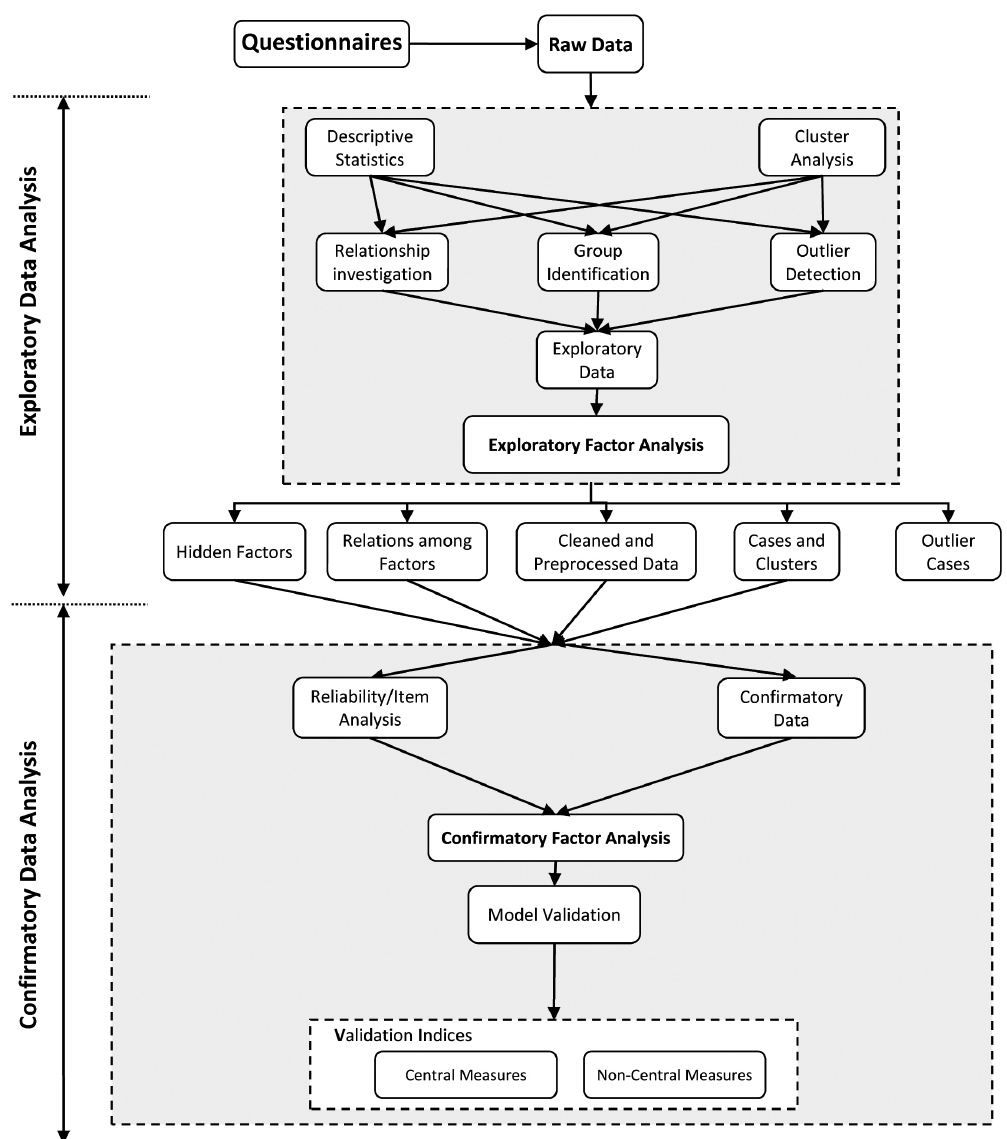
Figure 1: Three stages of EDA, CDA and model evaluation used in model validation The SMEs were also consulted during the model validation phase. This helped us examine the conceptual integrity of the model at each stage of the analyses. Figure 2 shows the iterative process that was used during model